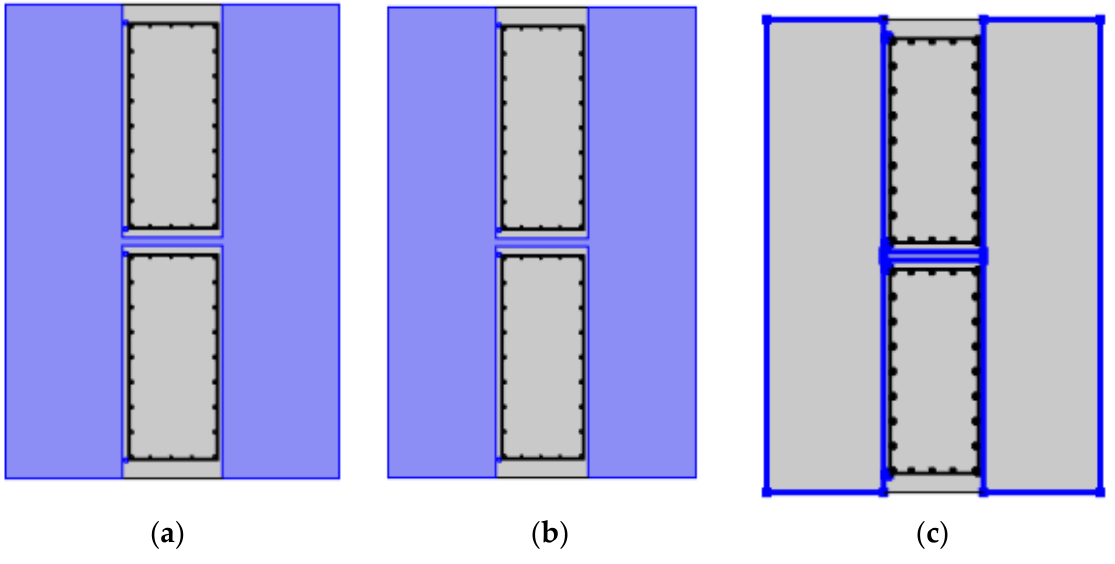
Figure 19. Conditions at the laminar flow interface; ( a ) Fluid properties; ( b ) Initial value; ( c ) Open boundary condition.